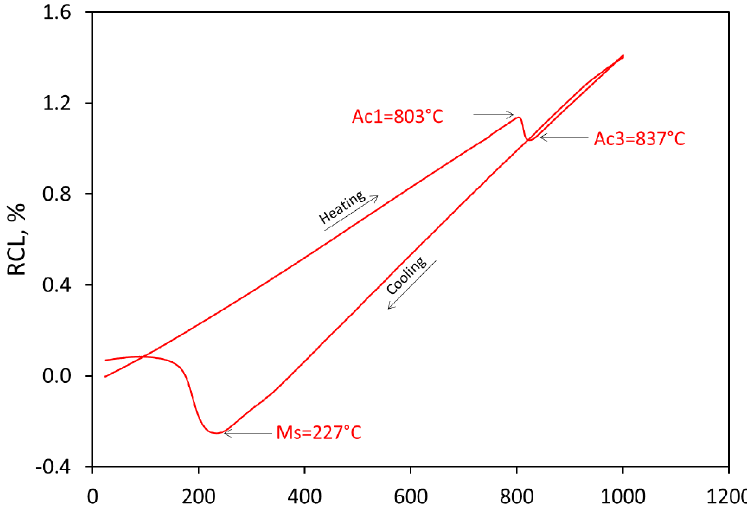
Figure 1. Results of high-resolution dilatometry testing to establish the austenitizing temperature and Ms.